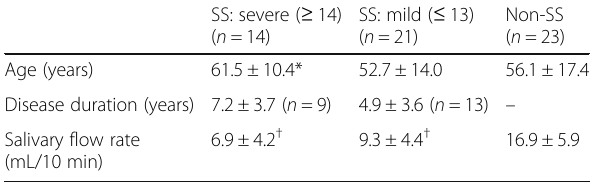
Table 3 Clinical characteristics of the SS and non-SS groups. Classification of the SS group by oral health-related quality of life (OHIP-14 score) SS: severe ( ≥ 14) SS: mild ( ≤ 13) Non-SS ( n = 14) ( n = 21) ( n = 23) Disease duration (years) 7.2 ± 3.7 ( n =